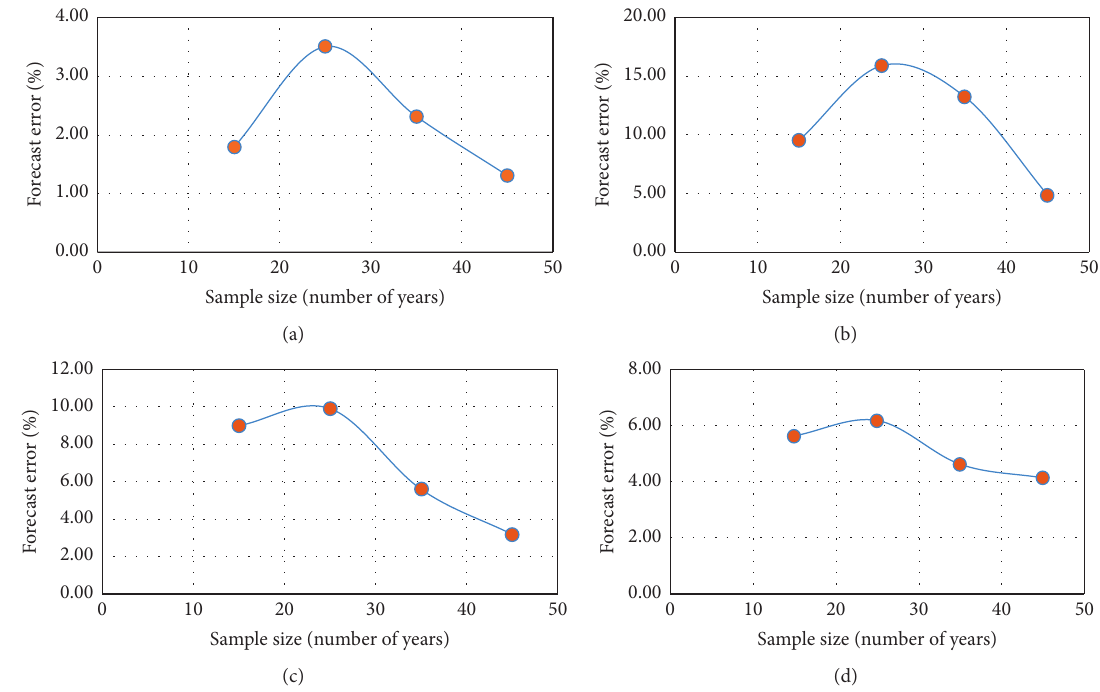
Figure 2: Forecast error for the subject countries, 2016. (a) Forecast error for Germany, 2016. (b) Forecast error for Denmark, 2016. (c) Forecast error for Israel, 2016. (d) Forecast error for Turkey, 2016.